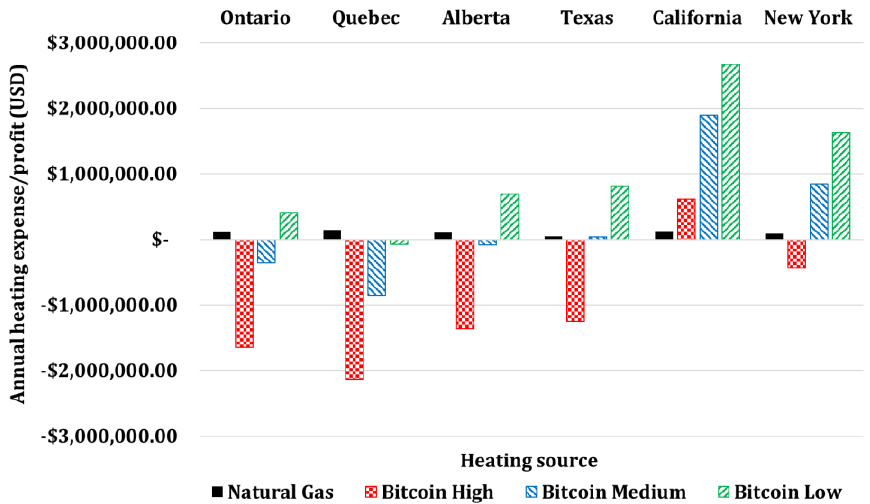
Figure 36. Annual heating expense/profit by natural gas and Bitcoin mining (after considering Bitcoin selling price) sources in six North American locations to heat Greenhouse 3.